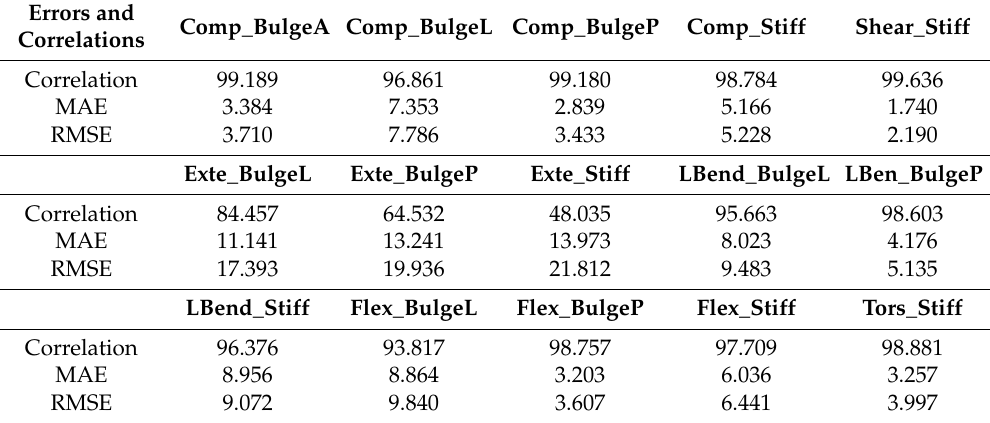
Table 26. Results of the predicted error criteria using the regression models.